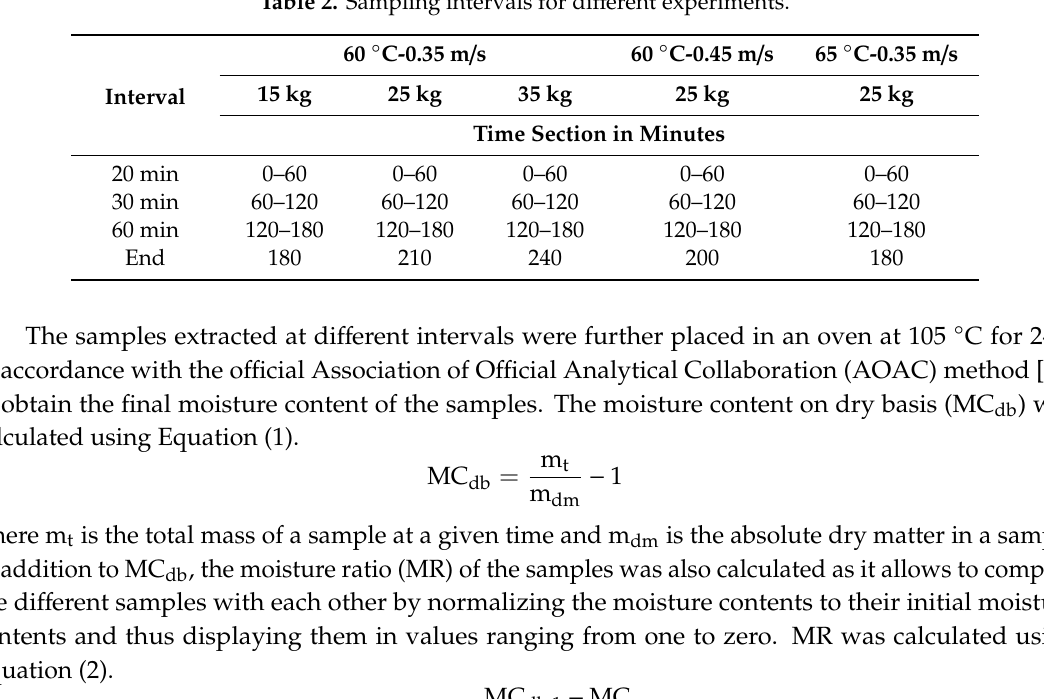
Table 2. Sampling intervals for di ff erent experiments.